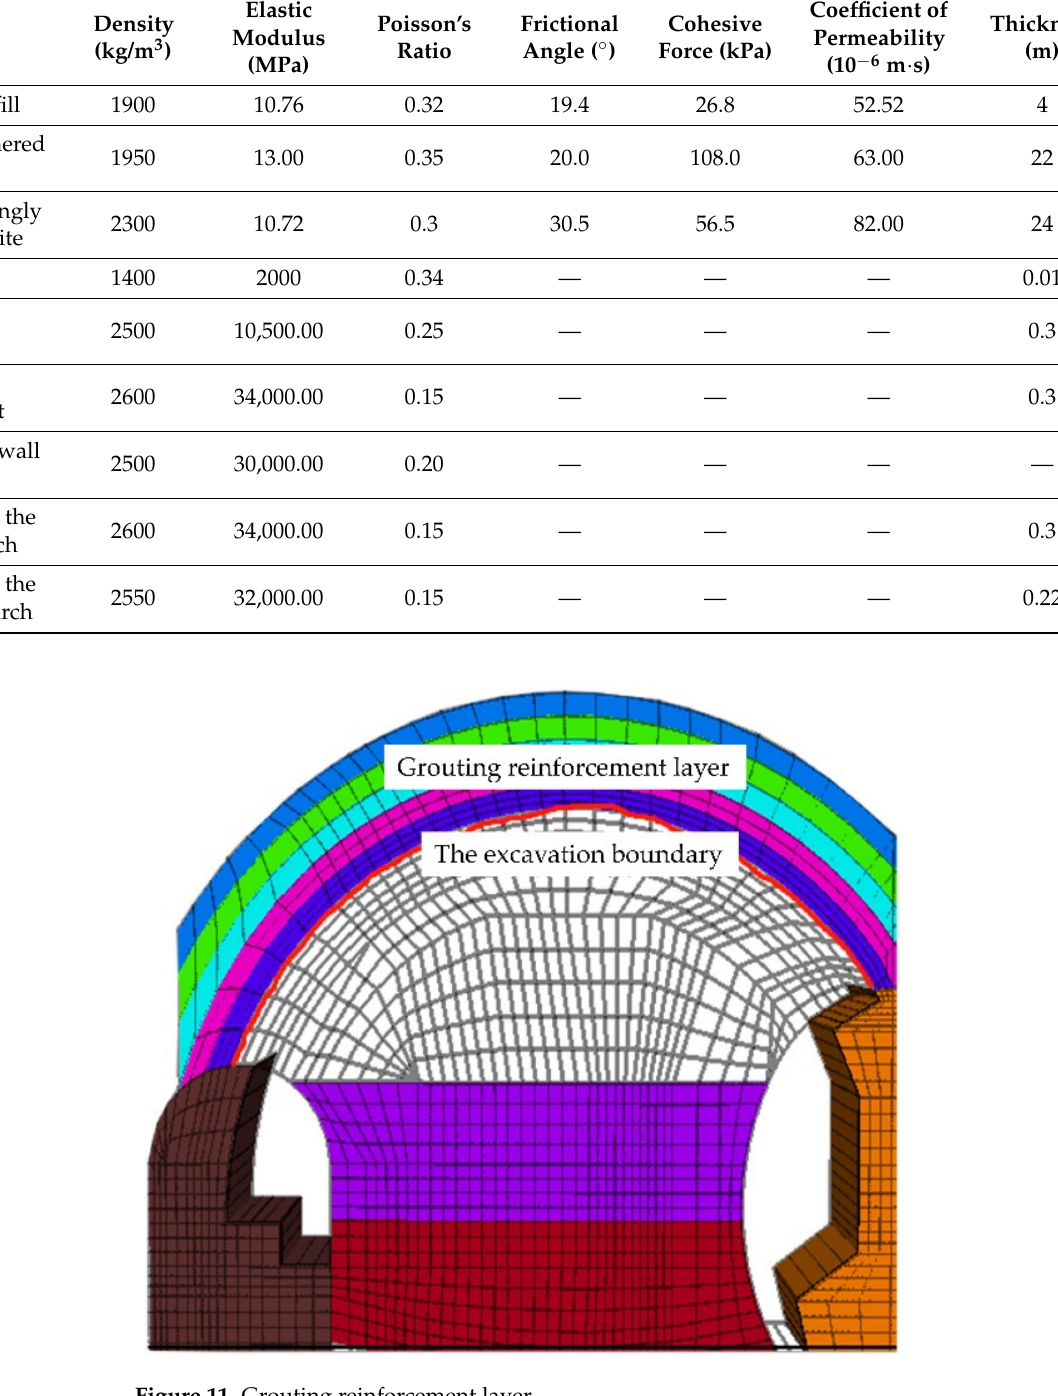
Figure 11. Grouting reinforcement layer.